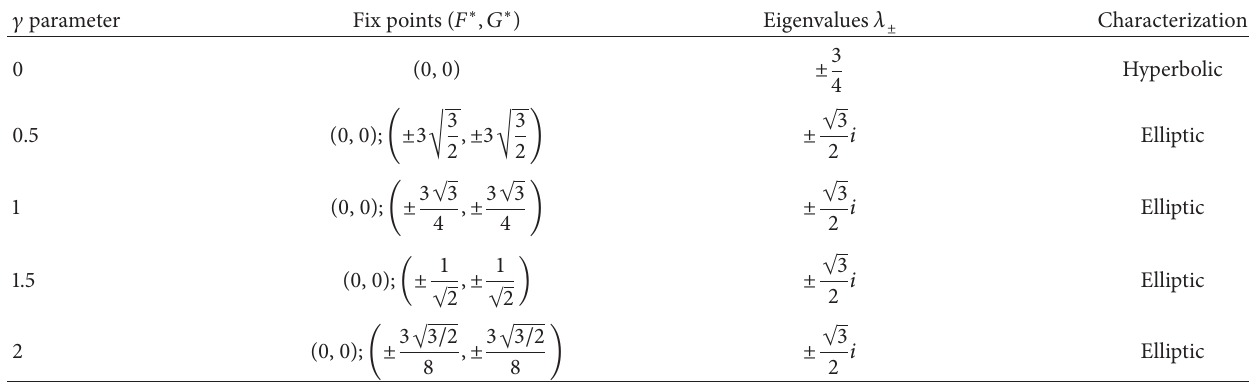
Table 2: Characterization of the fix points.